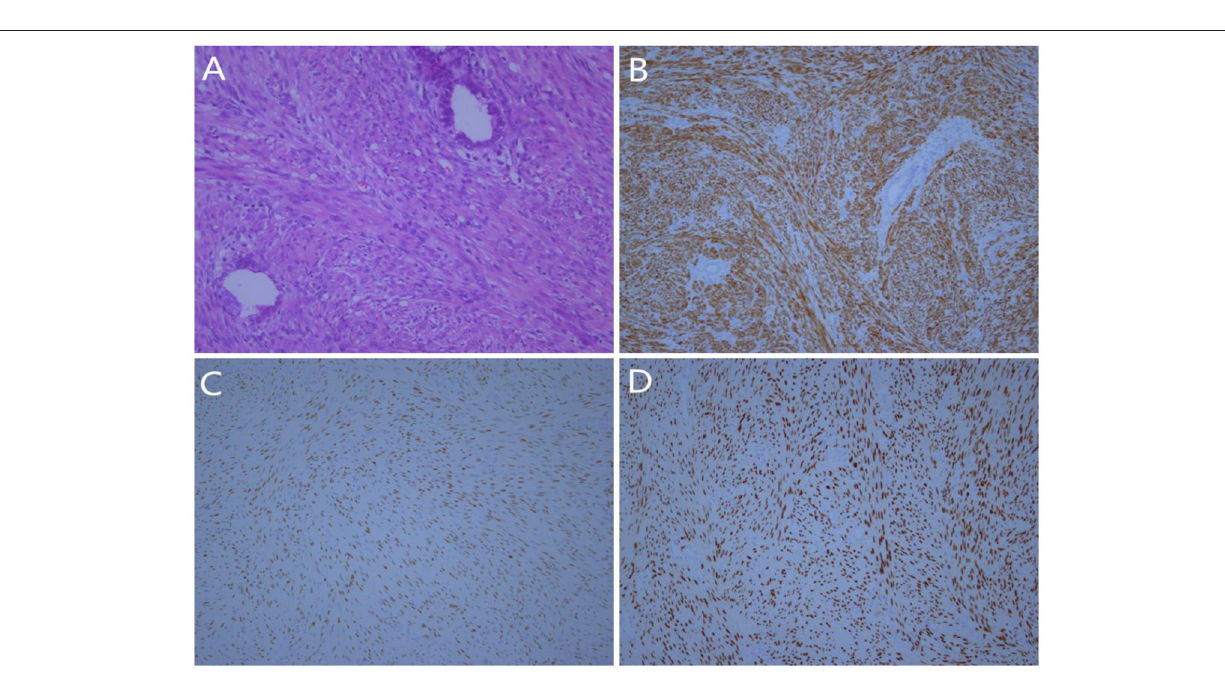
FIGURE 2 | Histologic findings: (A) Microscopically, the tumor was composed of proliferative spindled smooth muscle cells and endometrial glands (Hematoxylin and eosin stain, × 200); (B) The spindled smooth muscle cells were strongly positive for desmin (IHC, × 100); (C) Tumor cells were positive for ER (IHC, × 100); (D) The tumor cells were positive for PR (IHC, ×